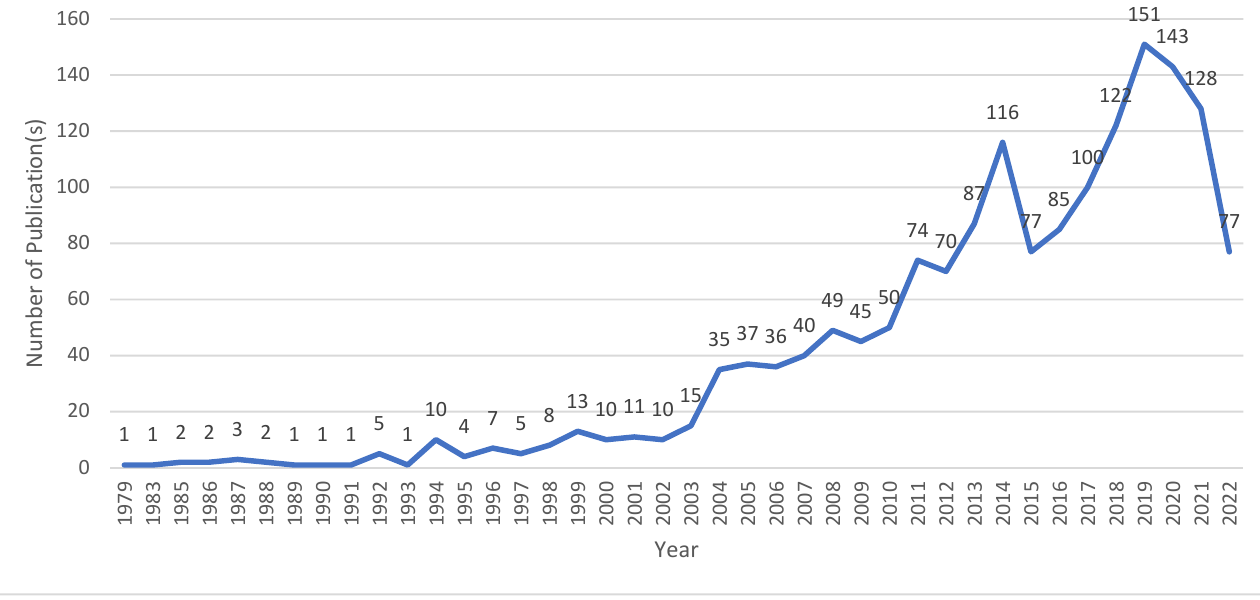
Figure 2. Annual publication trend.